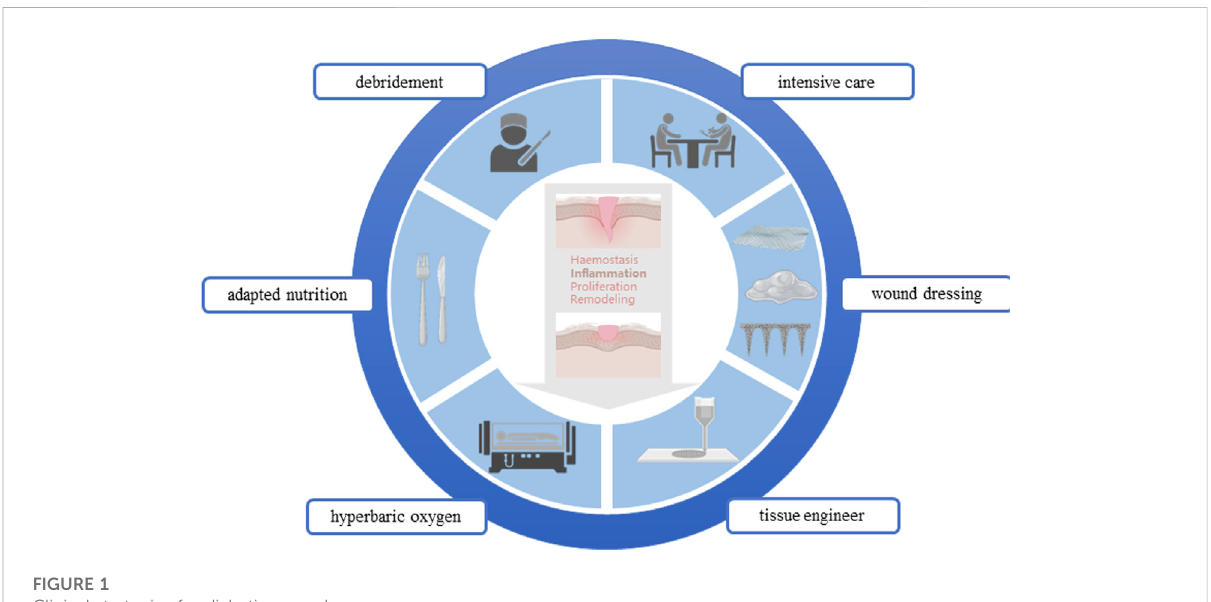
FIGURE 1 Clinical strategies for diabetic